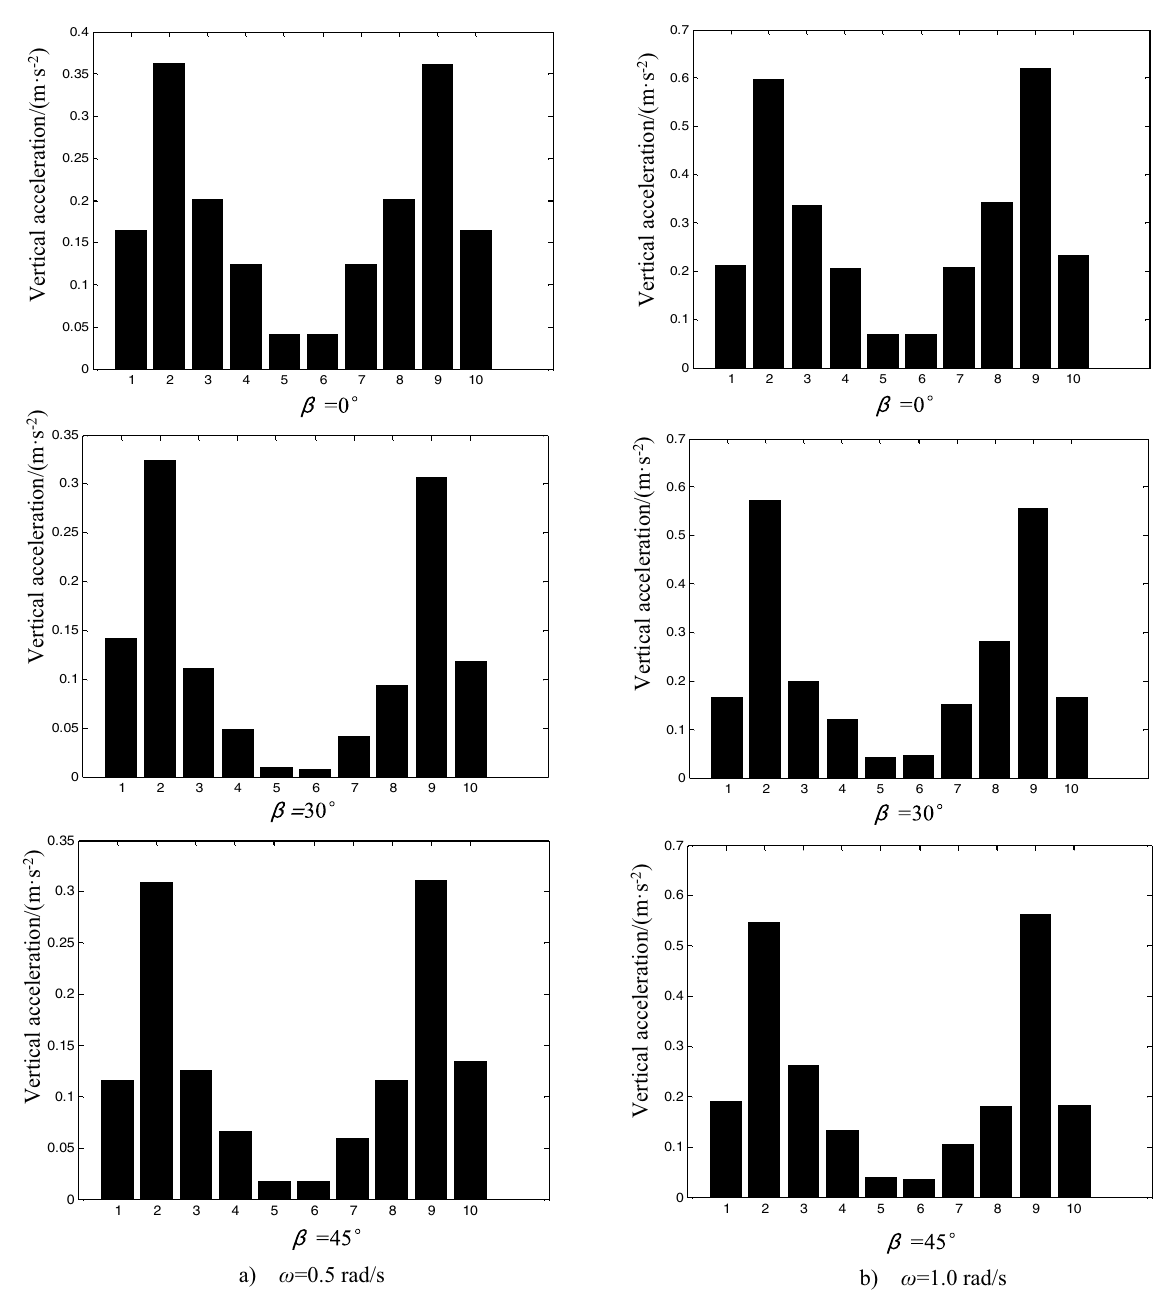
Fig. 12 Vertical acceleration of pontoons for different angles of incident